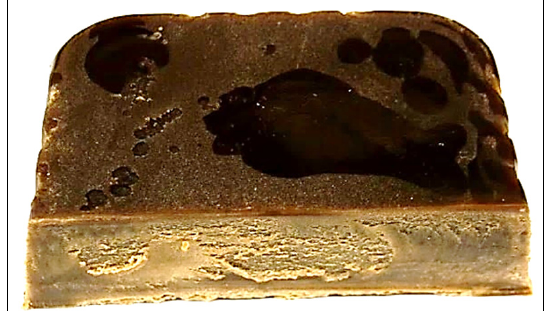
Figure 3. SonneWarmix RT TM sample. Table 12. Physical characteristics of SonneWarmix RT TM .